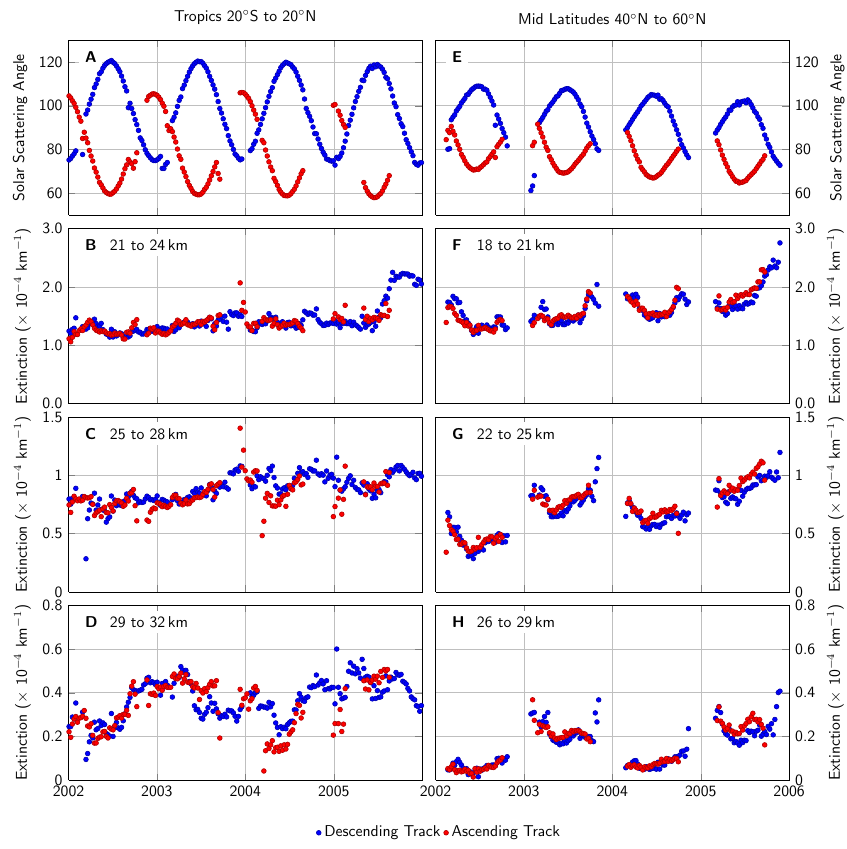
Fig. 11. Same as Fig. 2 except using version 6 Fig. 11. Same as figure 2 except using version 6 data.